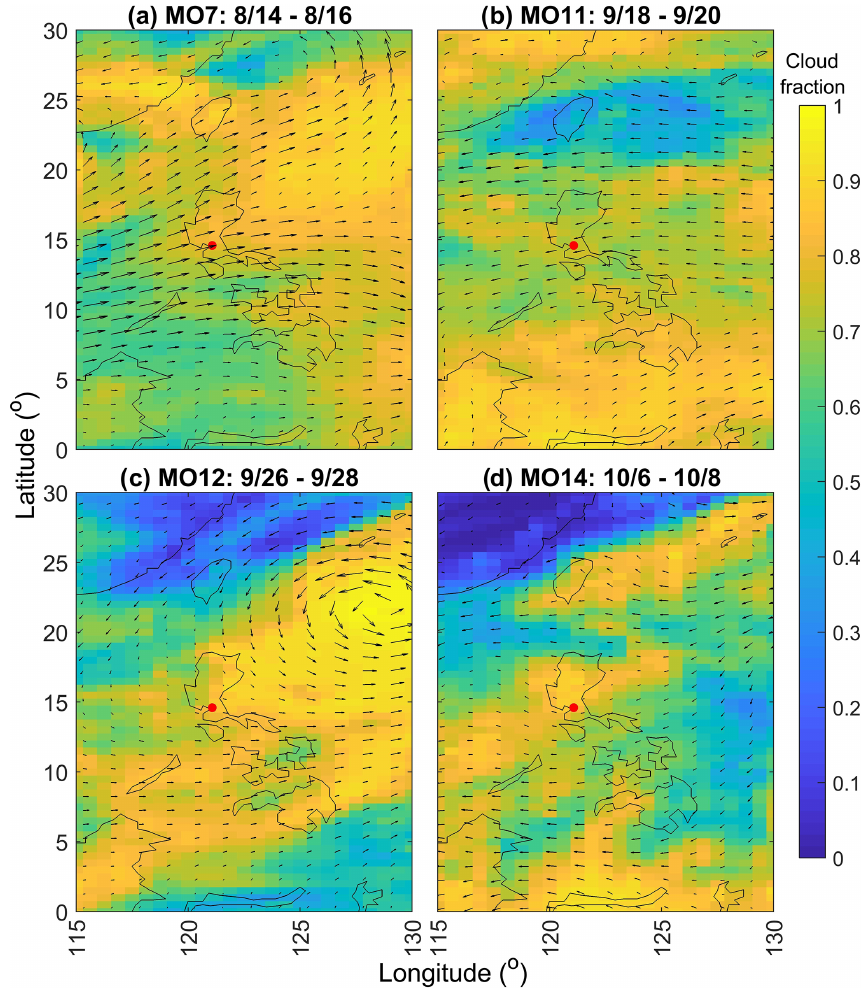
Figure 1. MERRA-2 data for 850 hPa wind vectors and total cloud fraction averaged over the sample set duration for (a) MO7 (14–16 August), (b) MO11 (18–20 September), (c) MO12 (26–28 September), and (d) MO14 (6–8 October). The location of the Manila Observatory is indicated by the red circle. (Note that 850hPa wind vectors are also averaged to increase grid spacing and improve figure